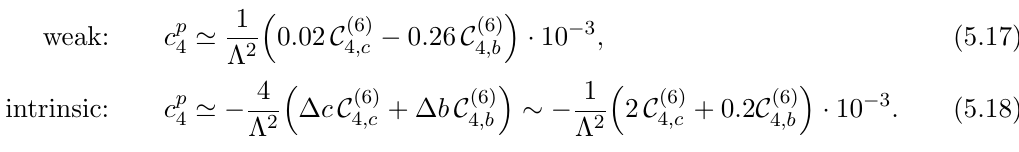
bottom quarks. For charm quarks the e(cid:11)ect of (cid:13)avor o(cid:11)-diagonal CKM matrix elements